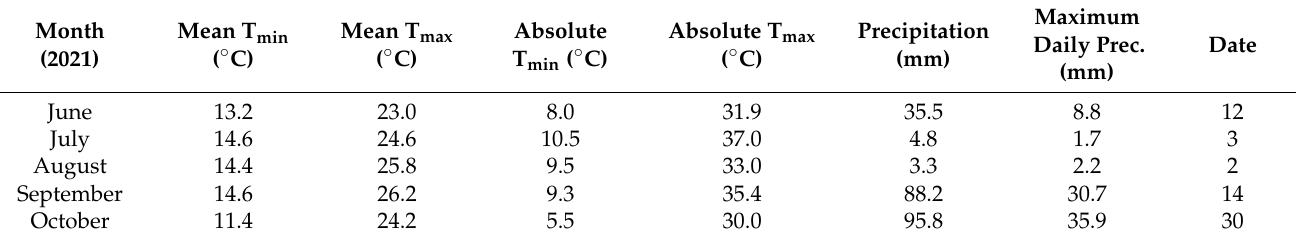
Table 1. Precipitation and temperature (T) data observed at Leiria weather station during the study period, in 2021. Last column indicates the date of occurrence of the maximum daily precipitation in a given month